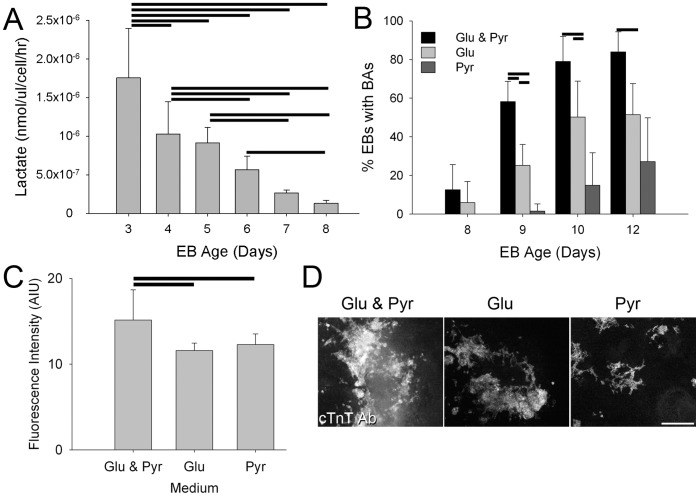
Lactate production and metabolic substrate requirements change with differentiation.A. Lactate production as detected in the medium on days 3 through 8 of mEB development. Horizontal lines indicate statistical difference (P<0.05) (Holm-Sidak method pairwise multiple comparison following repeated measures ANOVA). B. Percentage of mEBs that exhibited beating areas when cultured in either standard medium (Glu & Pyr), medium with glucose only (Glu) or medium with pyruvate only (Pyr) as assessed on days 8, 9, 10 and 12 after EB formation. Horizontal lines indicate statistical difference (P<0.05) (Tukey test following ANOVA). C. Quantitation of cTnT antibody labeling using fluorescence intensity measures from EBs grown with glucose and pyruvate, glucose only or pyruvate only. Horizontal lines indicate statistical difference (P<0.05) (Tukey pairwise comparison test following ANOVA). D. Examples of cTnT antibody labeling in EBs cultured in the 3 media. Scale bar = 500 µm.